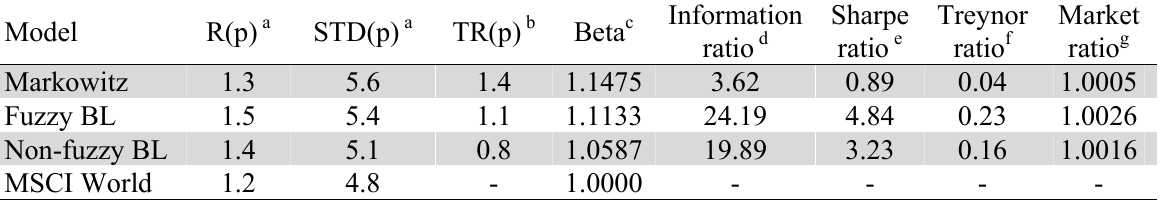
Risk/return characteristics of optimized portfolios, all figures in %, Observation period: Feb 2009 to Aug 2011